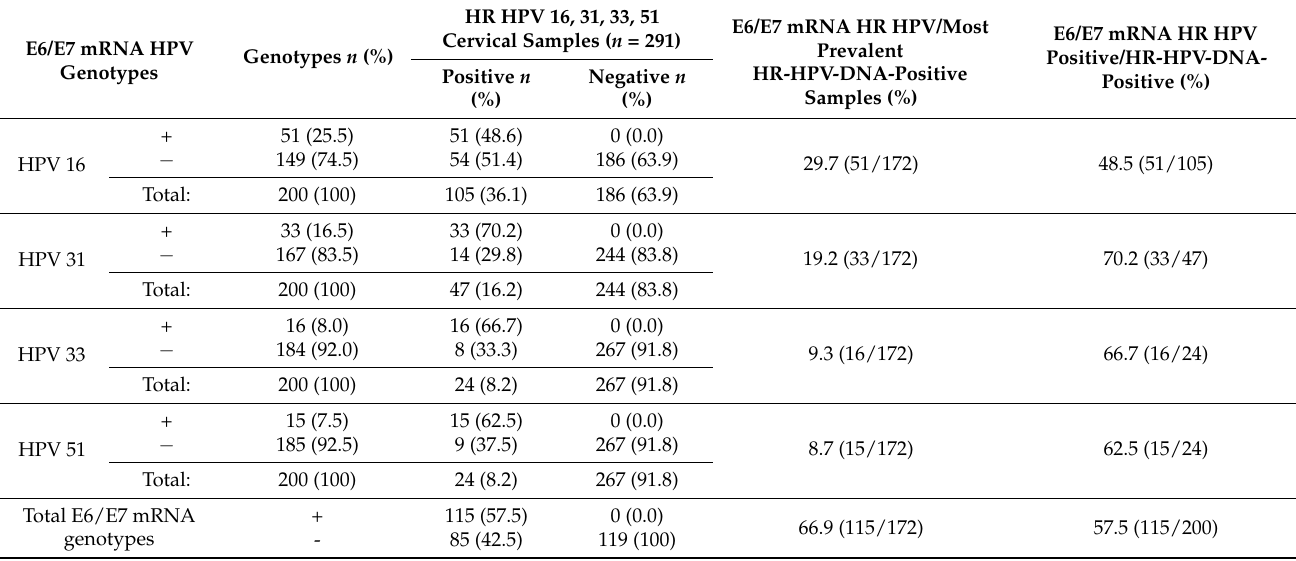
Table 6. Analyses of E6/E7 mRNA HPV 16, 31, 33, and 51 in cervical samples.